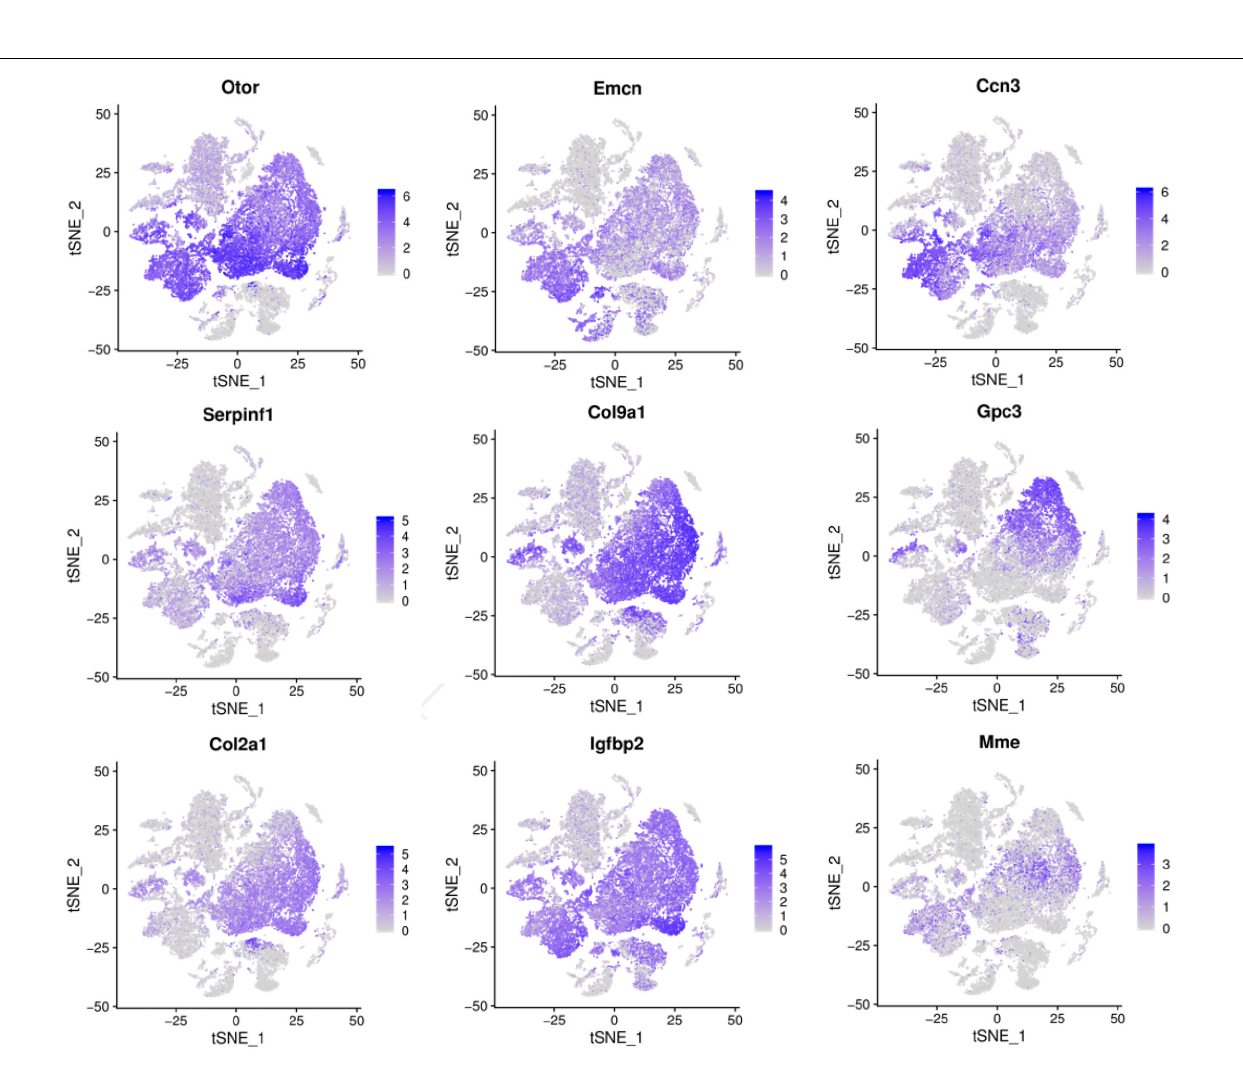
Frontiers in Molecular Neuroscience |